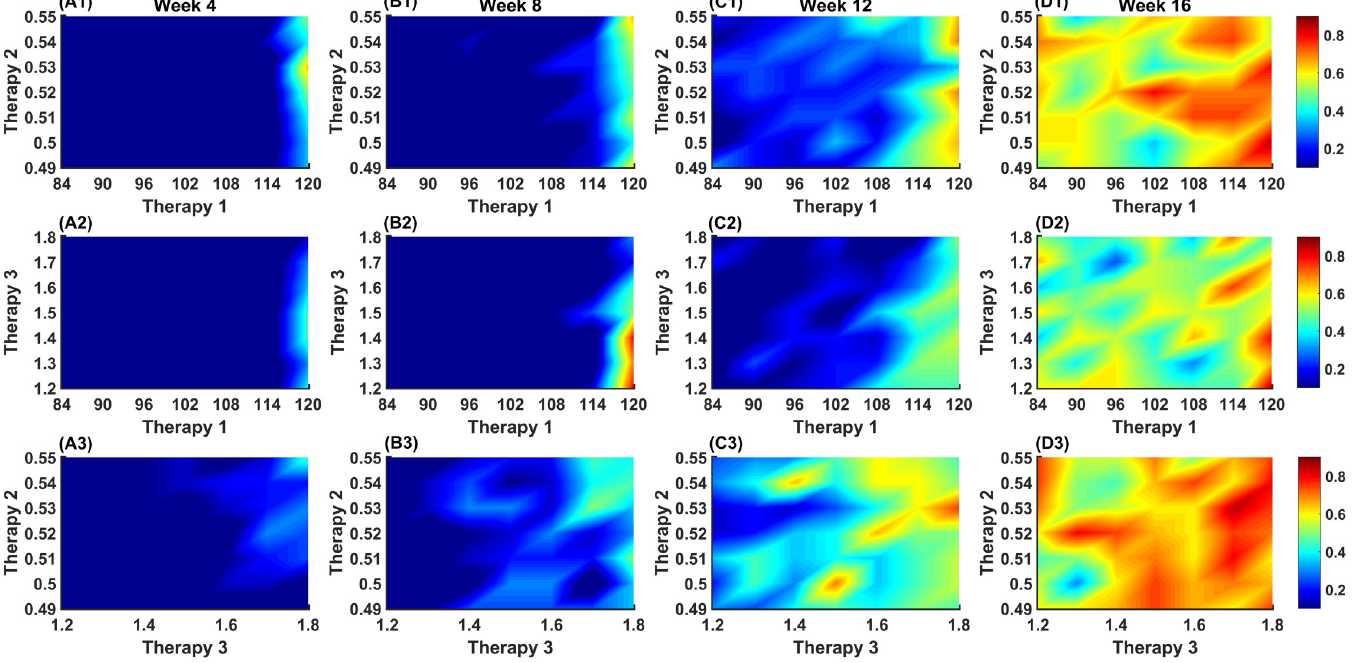
PLOS Computational Biology | https://doi.org/10.1371/journal.pcbi.1009413 September 27,